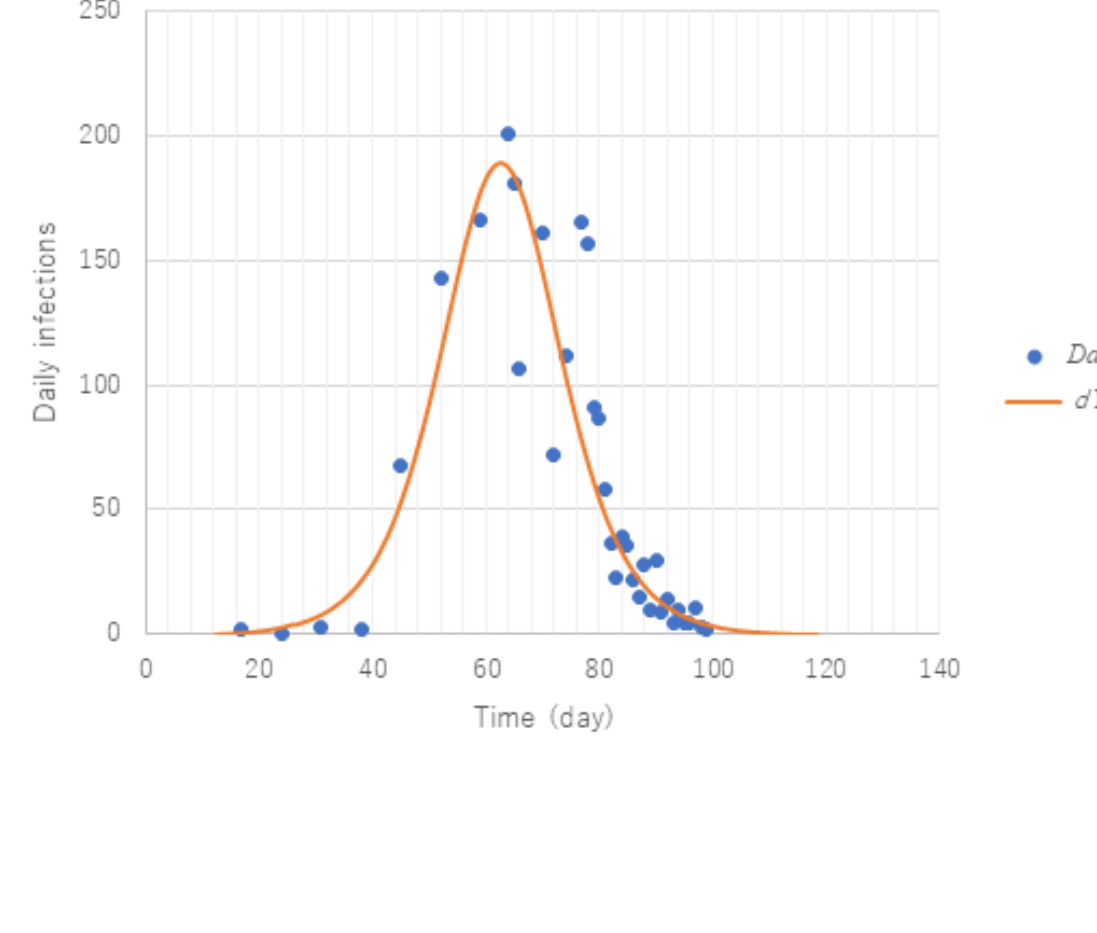
Figure 4. Simulation of daily new confirmed cases compared with observed data. Model PART1 with the same parameter values as in Figure 3 was used. Note that dY/dt = dx ( t – T )/ dt since nearly 2 weeks are needed in Japan to confirm infection by polymerase chain reaction